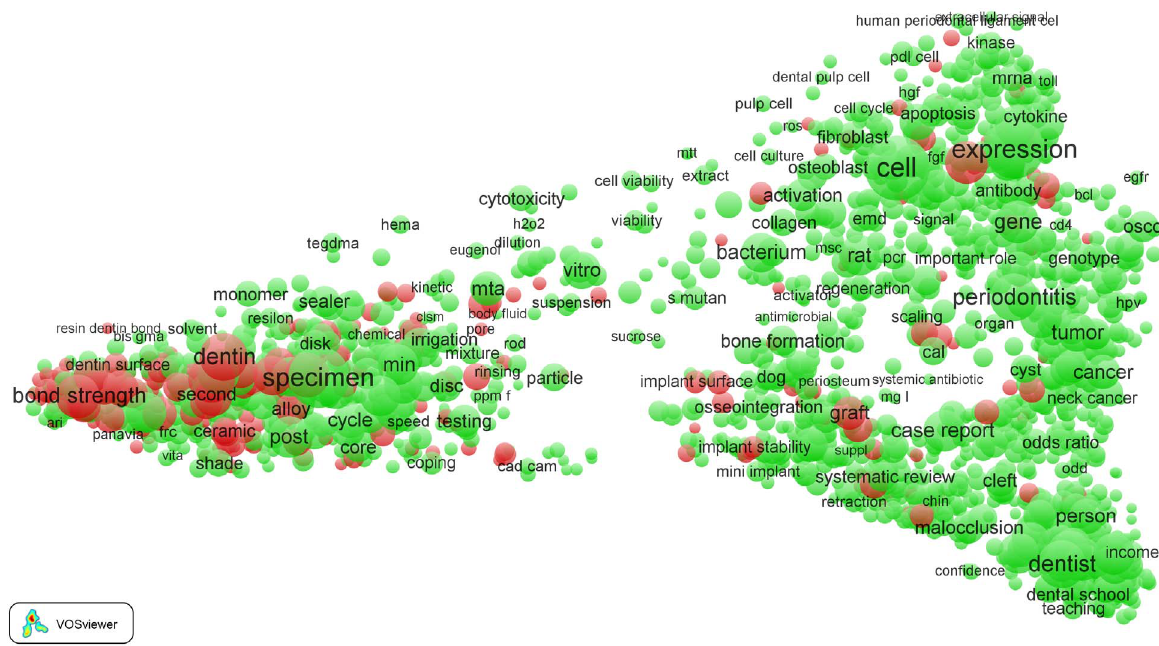
Figure 5. Term map of the Dentistry field.